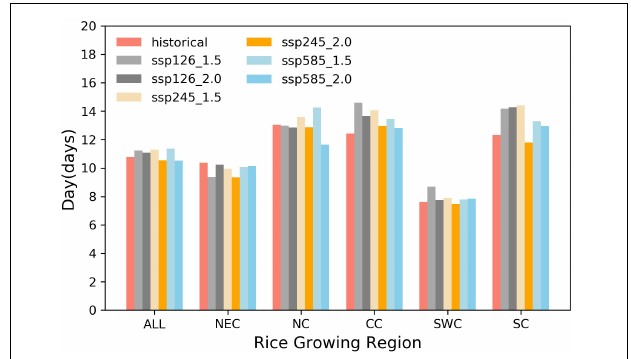
FIGURE 6 | Regional average of consecutive dry days (CDD) at the historical temperature and 1.5 and 2 ◦ C temperature increases. The rice-growing regions are the Chinese rice-growing region (ALL), Northeast China rice-growing region (NEC), North China rice-growing region (NC), Central China rice-growing region (CC), Southwest China rice-growing region (SWC), and South China rice-growing region (SC).